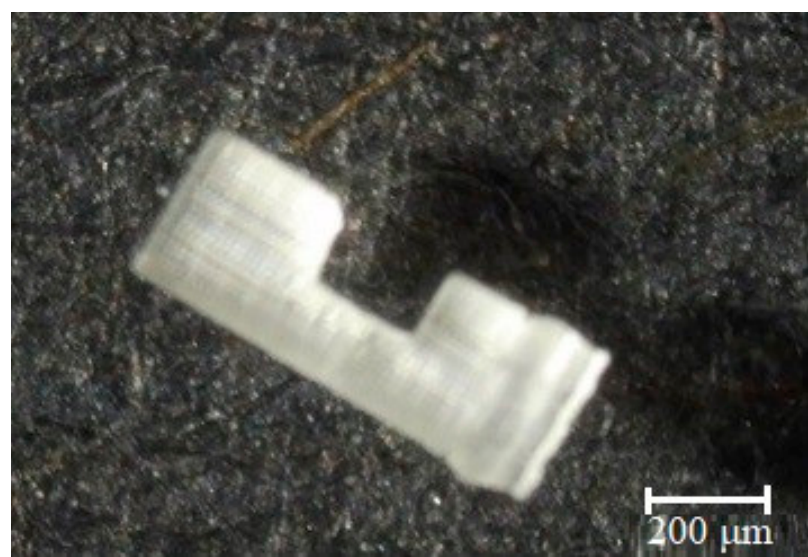
Figure 6. Image of the micro beam fabricated with the DLP method.